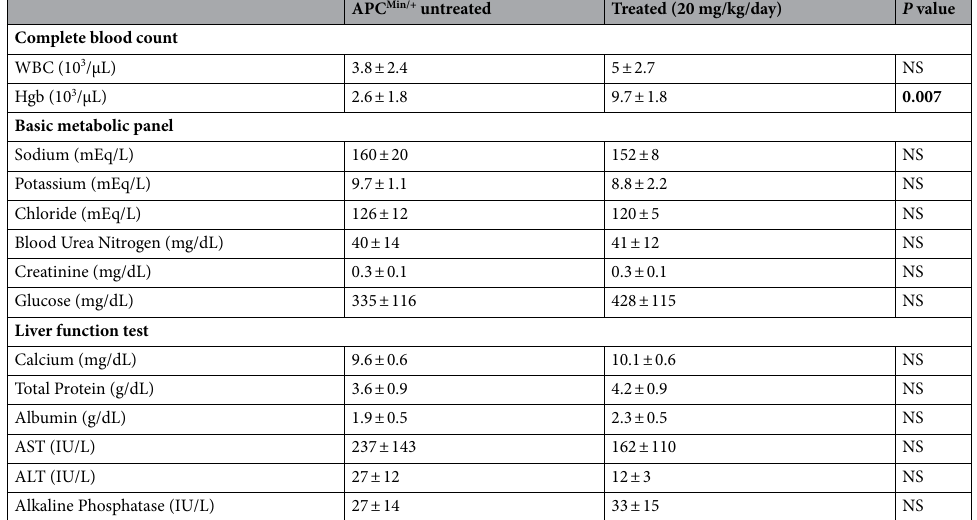
Table 1. Blood, metabolite and liver function results from APC Min/+ mice included in Study B. There were no statistically significant differences between the blood and liver function values between these groups. However, both groups exhibited hypernatremia, hyperkalemia, hyperchloremia, uremia, hypoalbuminemia, hypoproteinemia and AST (aspartate aminotransaminase) elevations. The blood study shows a significant reduction in hemoglobin levels of untreated APC Min/+ mice relative to treated mice, indicating anemia characteristic of bleeding in untreated APC Min/+